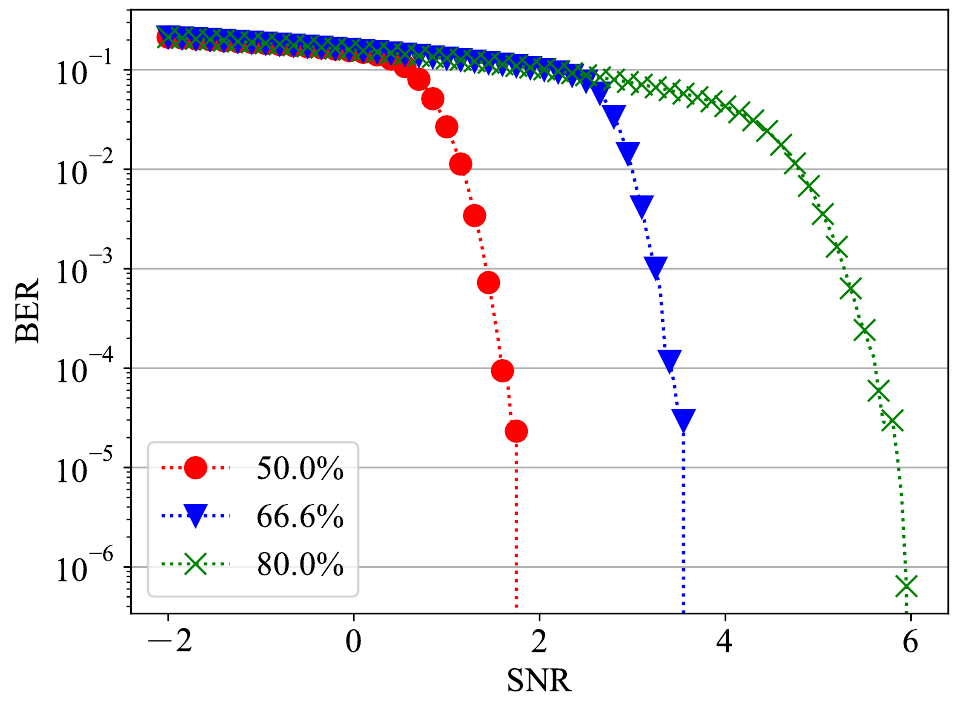
Figure 2. Different data rates correspond to different BERs at the same